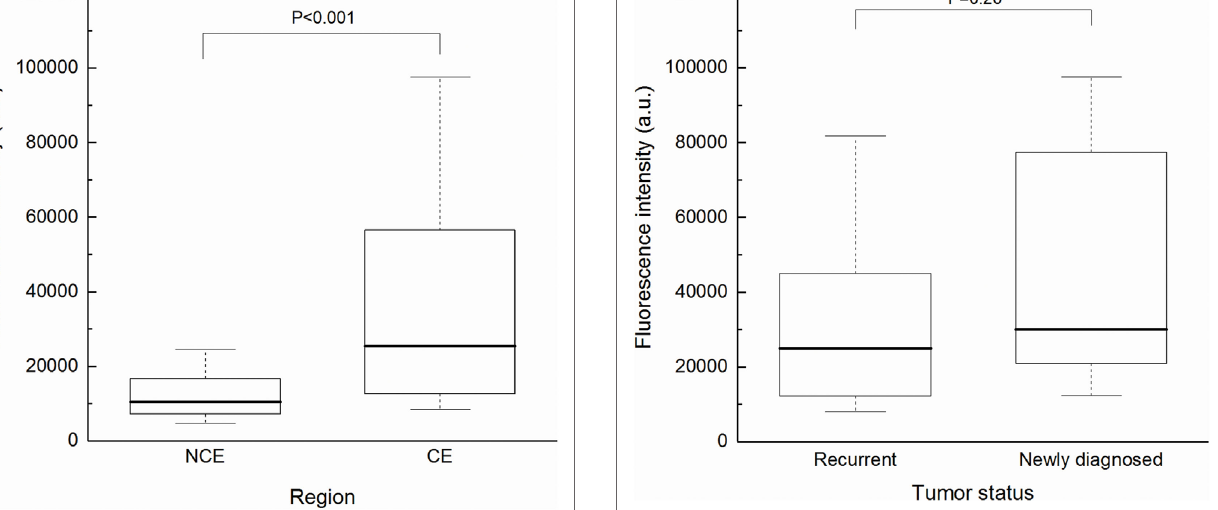
FigUre 3 | Fluorescence intensity according to tissue region. The CE group ( n = 41) showed significantly higher intensity than the NCE group ( n = 45) by Mann–Whitney U test ( P < 0.001). Each box indicated the interquartile range, and the median was shown with a bold line. The ends of the whiskers represented the 10th and the 90th percentile. a.u., arbitrary units; CE, contrast-enhanced; NCE, non-contrast-enhanced.